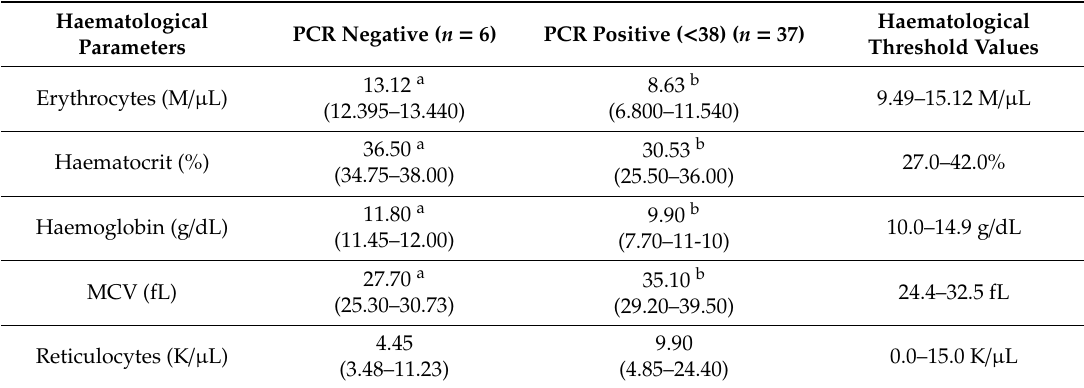
Table 1. Haematological parameters (median value and 25th and 75th percentile values) of A. ovis PCR negative and positive lambs (threshold value <